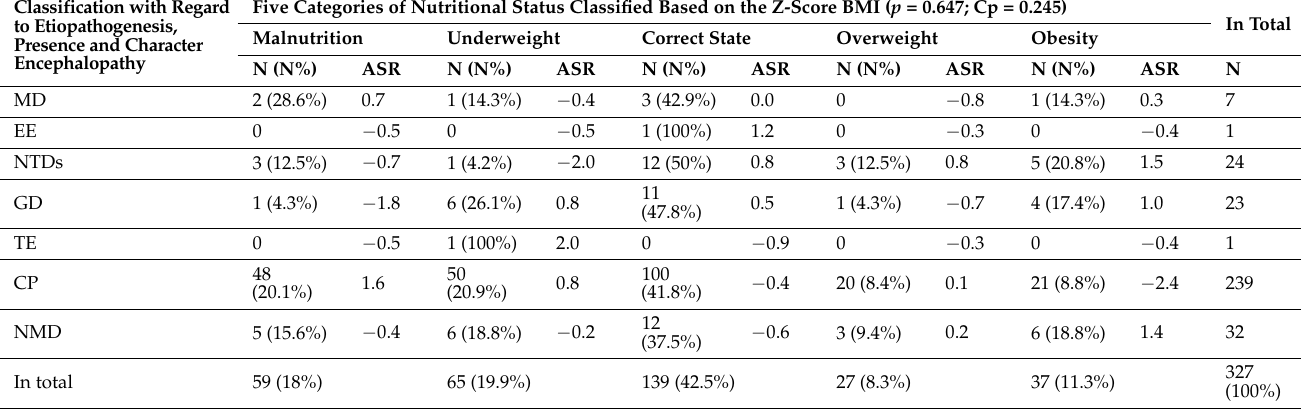
Table 6. Relationship between five categories of nutritional status classified based on the BMI z-score and classification with regard to etiopathogenesis, presence and character